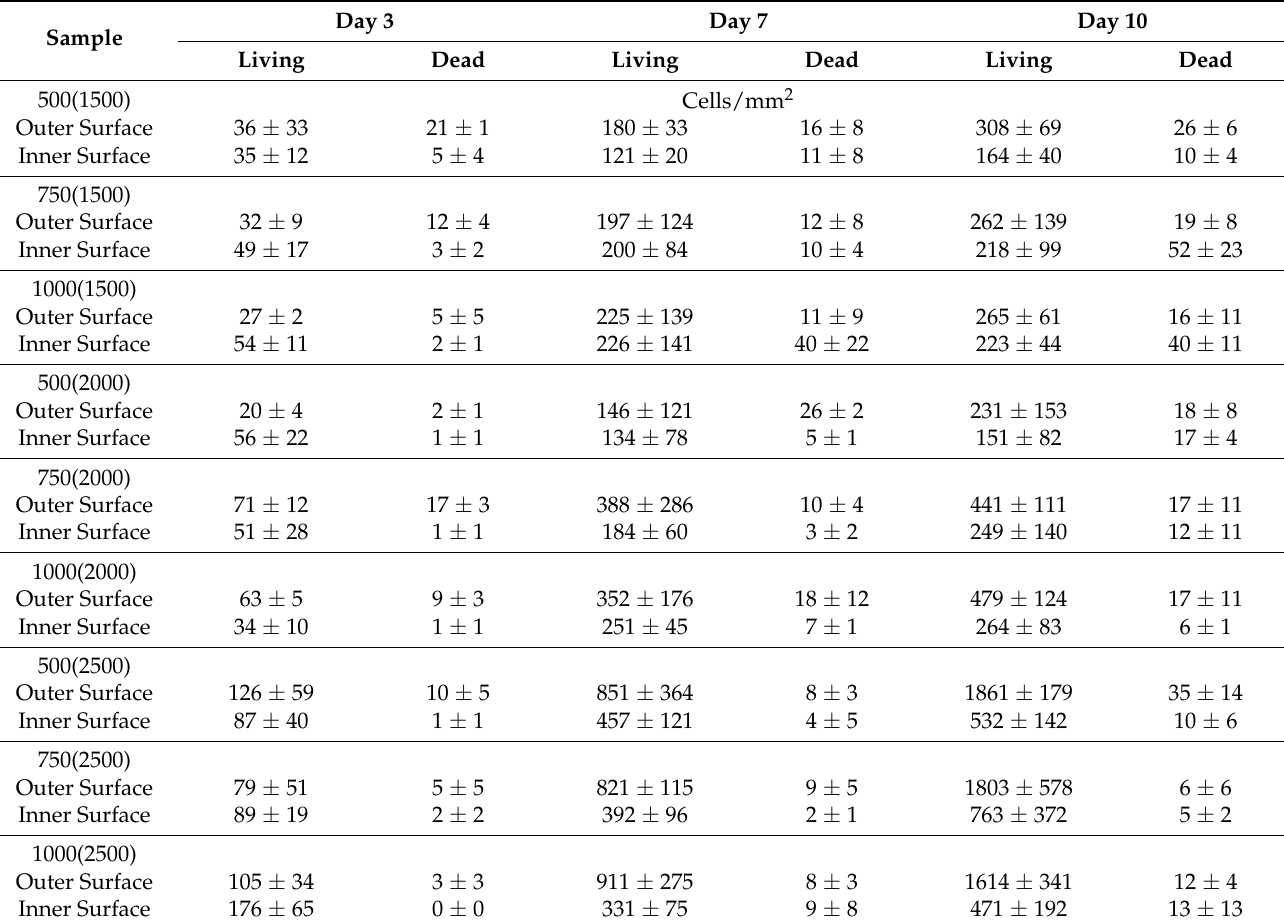
Table 6. Overview of living/dead cells for the different sized (pores, band widths)